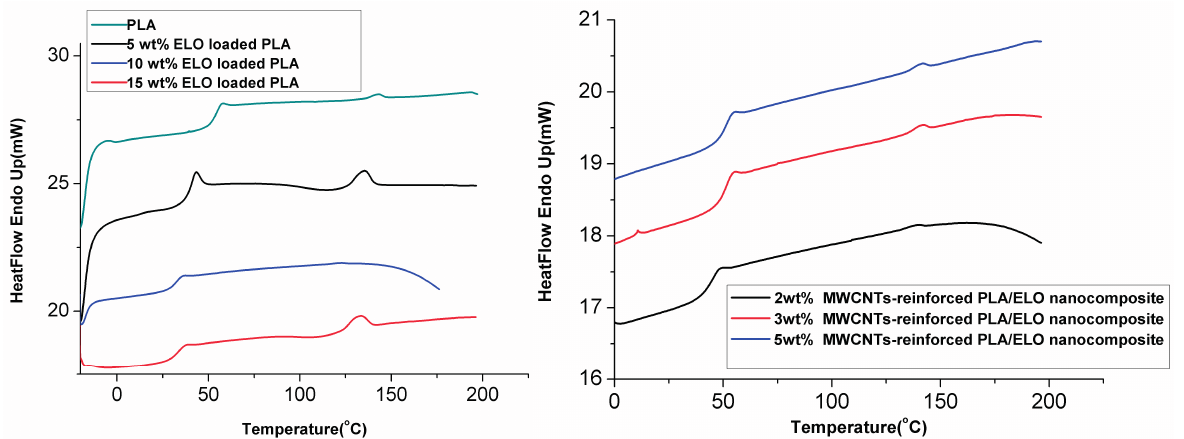
Figure 3. Differential Scanning Calorimetry (DSC) thermograms of ELO plasticized PLA, and MWCNTs-reinforced PLA/ELO nanocomposites.